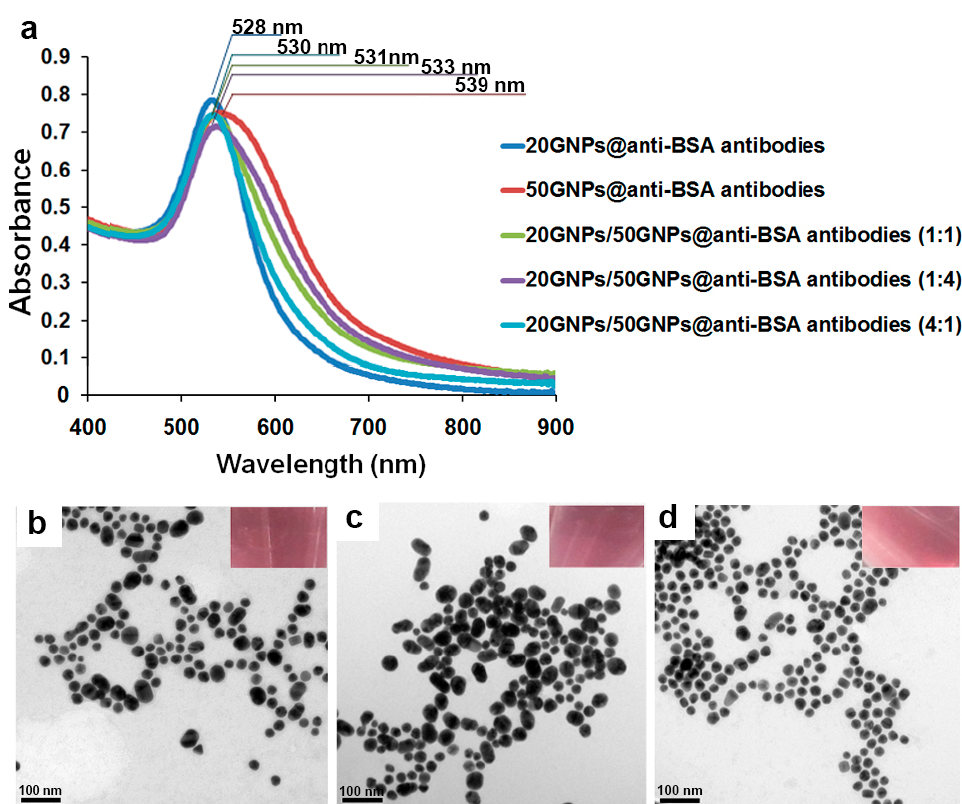
Figure 5. ( a ) Light absorption spectra of the 20GNPs@anti-BSA, 50GNPs@anti-BSA, and mixed-sized GNPs@anti-BSA conjugates. TEM images of 20GNPs@anti-BSA and 50GNPs@anti-BSA conjugates at different mixing ratios: ( b ) 1:1; ( c ) 1:4; and ( d ) 4:1. The TEM images of the mixed 20GNPs@anti-BSA and 50GNPs@anti-BSA conjugates